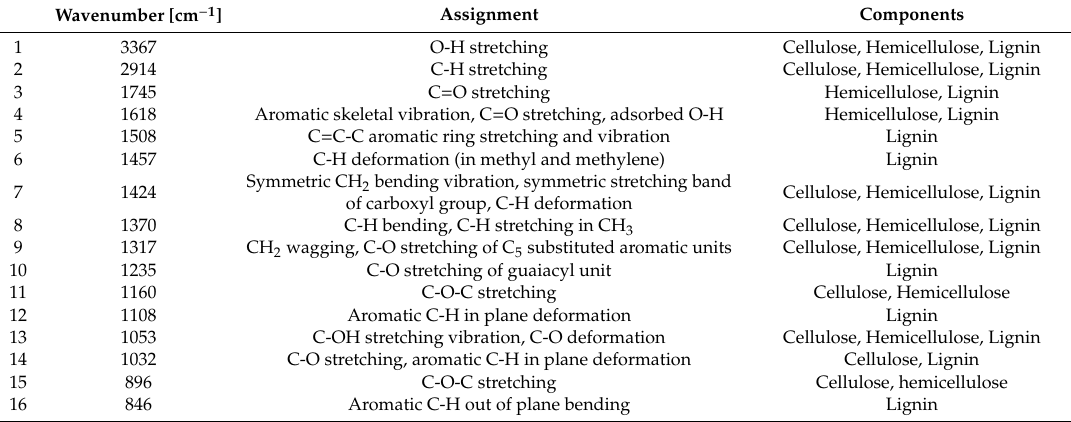
Table 1. Fourier transform infrared (FTIR) band assignments of poplar and its major components: cellulose, hemicellulose, and lignin